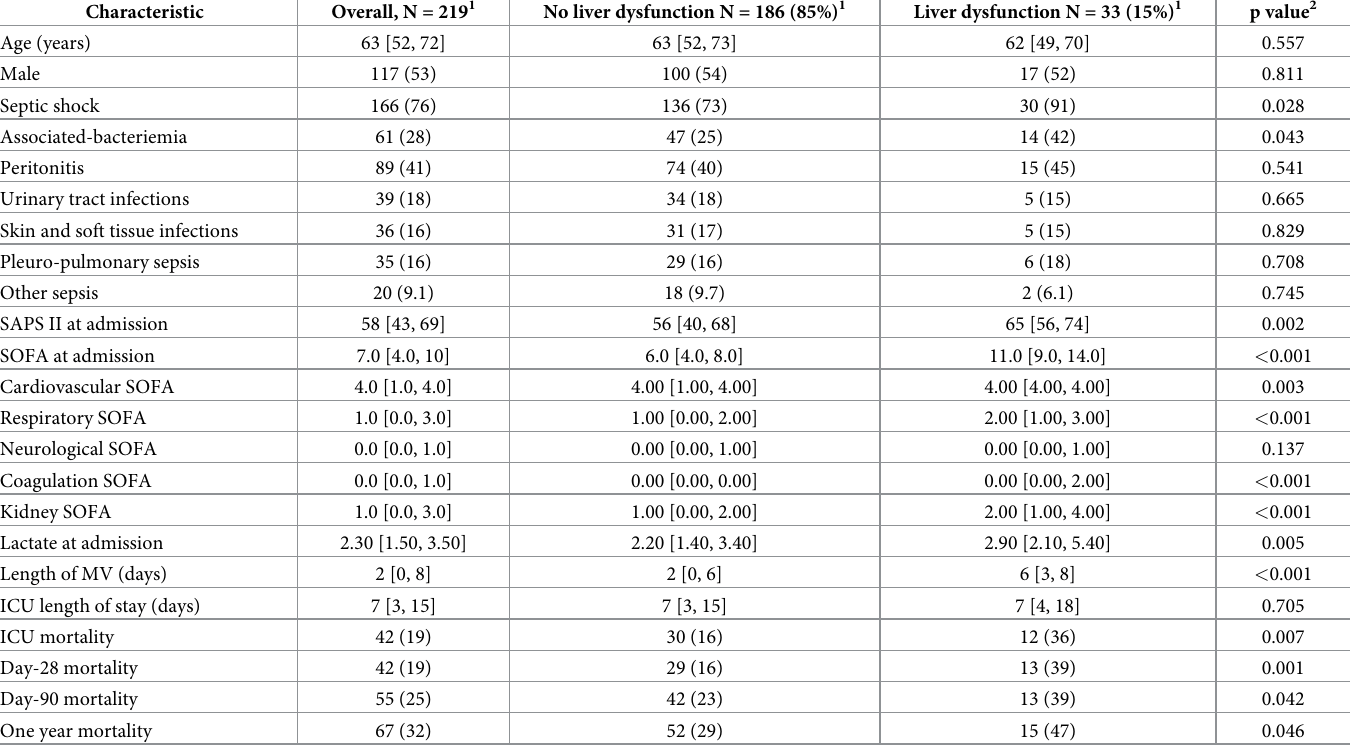
Table 1. General characteristics of the population, outcome and type of sepsis, overall and according to sepsis-associated liver dysfunction.